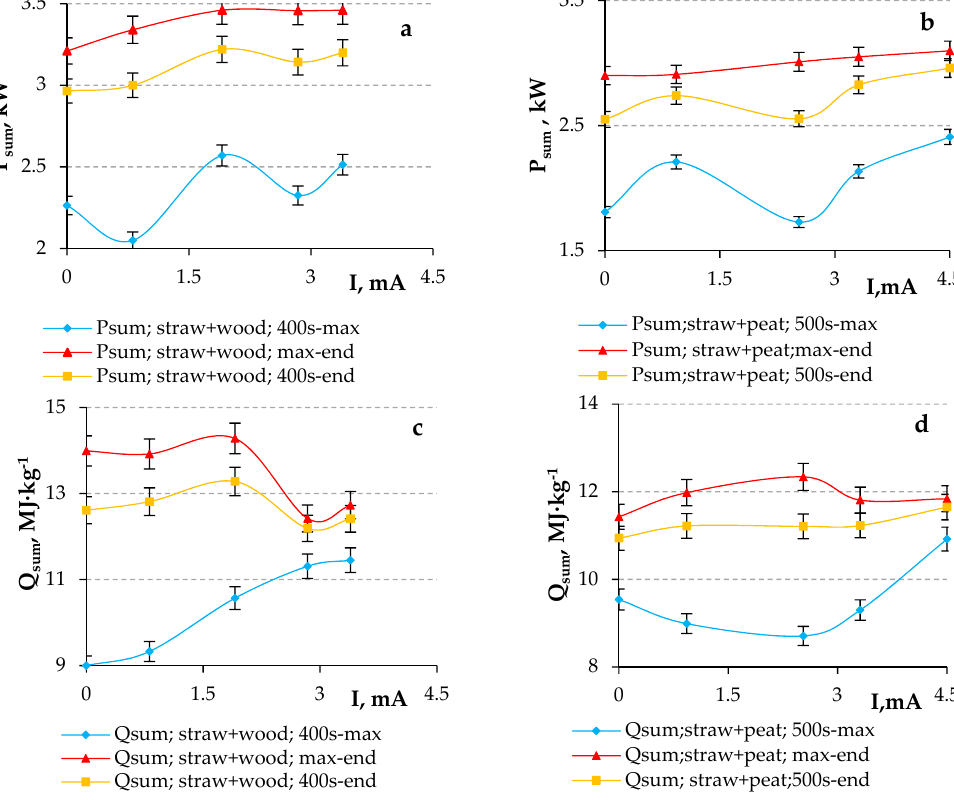
Figure 9. Electric field e ff ect on the heat output from the device ( a , b ) and on the produced heat per mass of burned mixture ( c , d ) when co-firing straw (30%) with wood ( a , c ) or with peat ( b , d ) pellets.